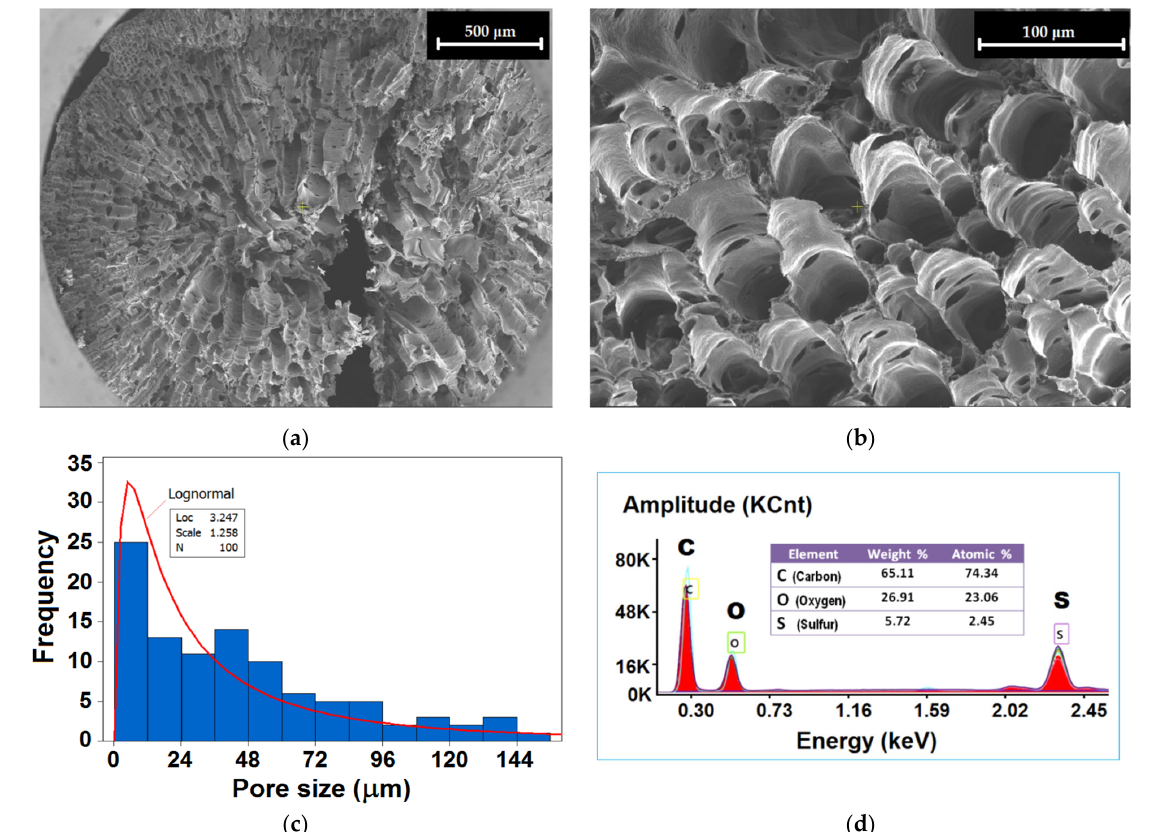
Figure 1. Porous morphology and characteristics of the sulfonated polymer SPEEK: ( a , b ) SEM images of the cross-section of a polymeric bead—SPEEK; ( c ) histogram of the pore size distribution; and ( d ) EDX spectrum for the solid surface of the SPEEK adsorbent.